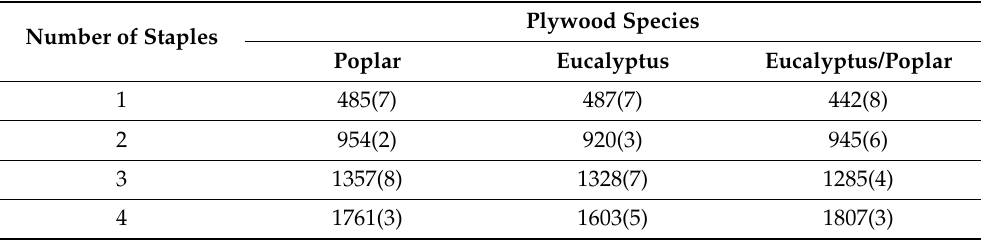
Table 4. Average comparisons of maximum lateral holding loads of one-row multi-stapled joints for plywood species with different numbers of staples.